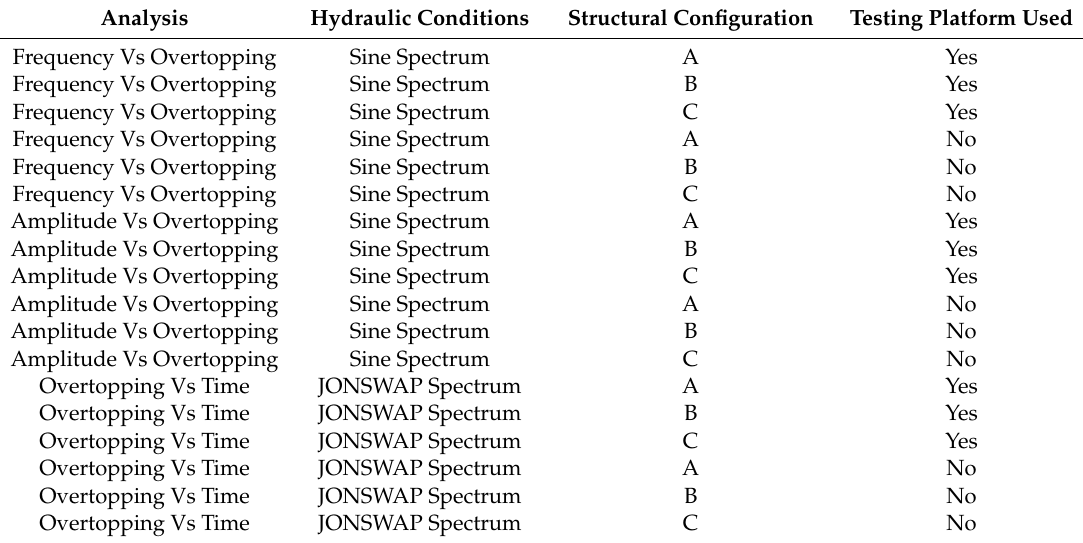
Table 3. Experimental testing